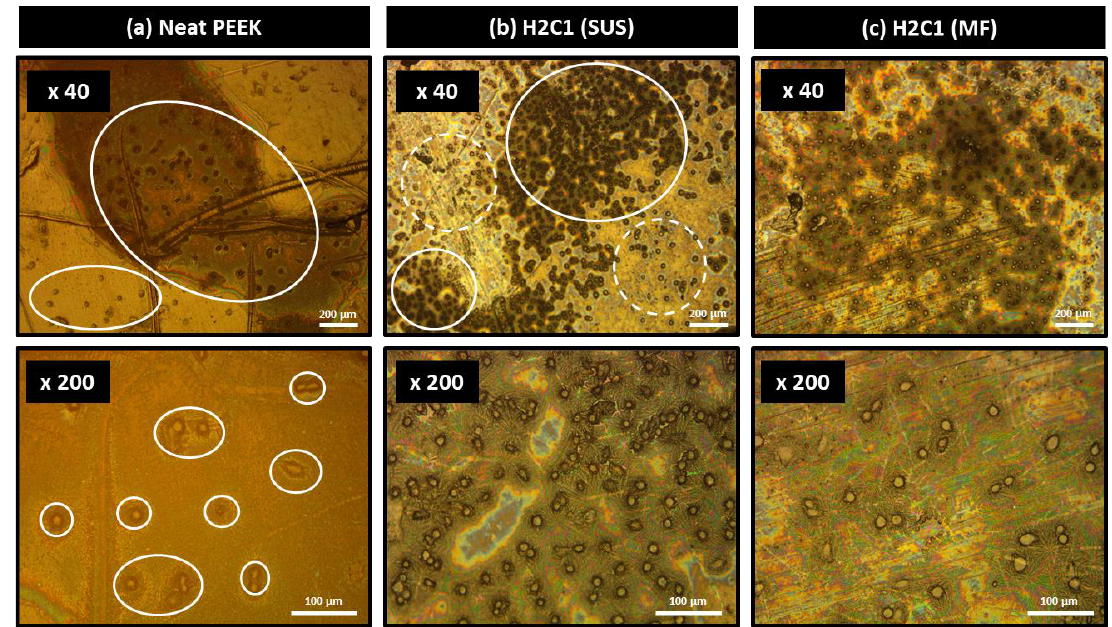
Figure 6. Optical microscope images of cell adhesion morphology on the substrates of PEEK composites; ( a ) neat PEEK, ( b ) H2C1 (SUS), ( c ) H2C1 (MF).